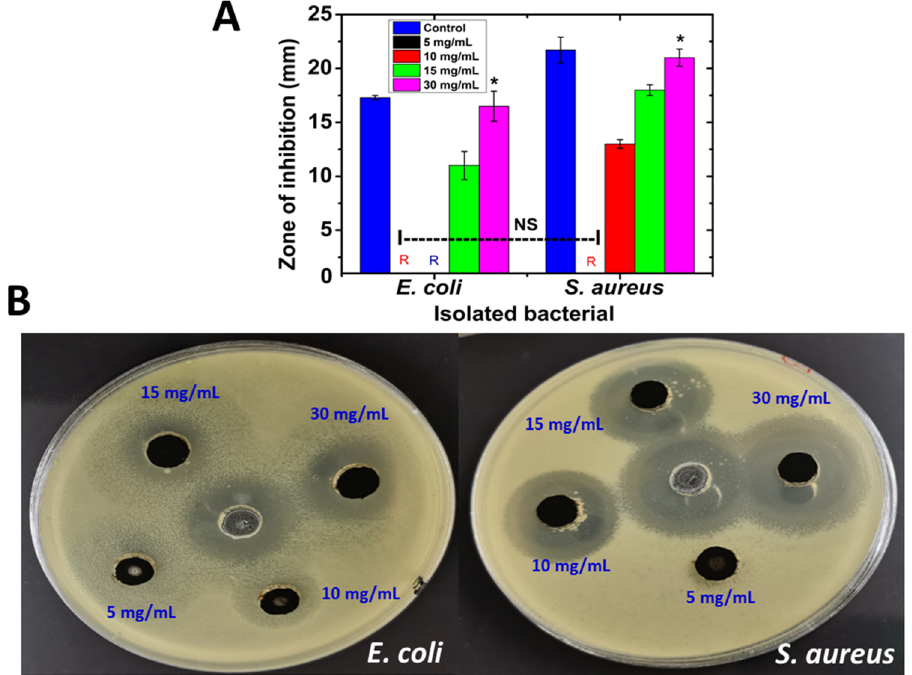
Figure 10. SRLe - α Fe 2 O 3 NPs inhibit E. coli and S. aureus bacterial growth. The inhibitory effect of SRLe - α Fe 2 O 3 NPs compared with erythromycin as a standard antibiotic control was determined in vitro using an agar well diffusion assay. ( A ) Zones of inhibition (mm). Each column shows the mean ± SD of three independent experiments. * Statistically significant difference ( p < 0.05); NS represents a nonsignificant differences ( p > 0.05) compared to the control sample. The symbol “R” indicates resistance to the studied bacterial strains. ( B ) Bacterial zones of inhibition (mm) on E. coli and S. aureus plates with diverse concentrations (5, 10, 15, and 30 mg/mL) of SRLe - α Fe 2 O 3